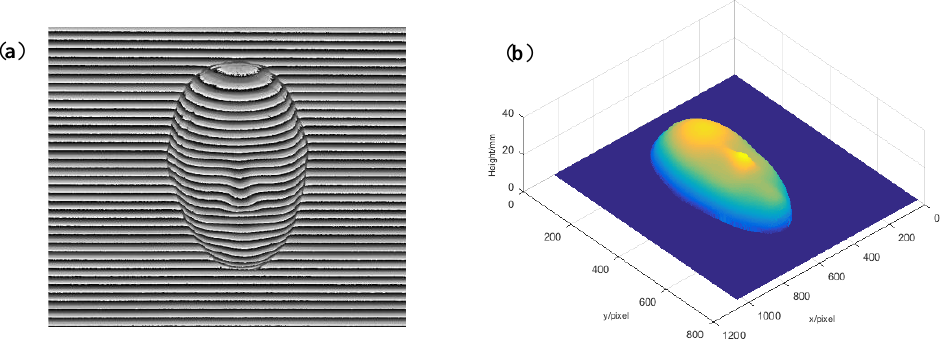
Figure 6. The experimental results: ( a ) wrapped phase of measured object; and ( b ) reconstructed object.